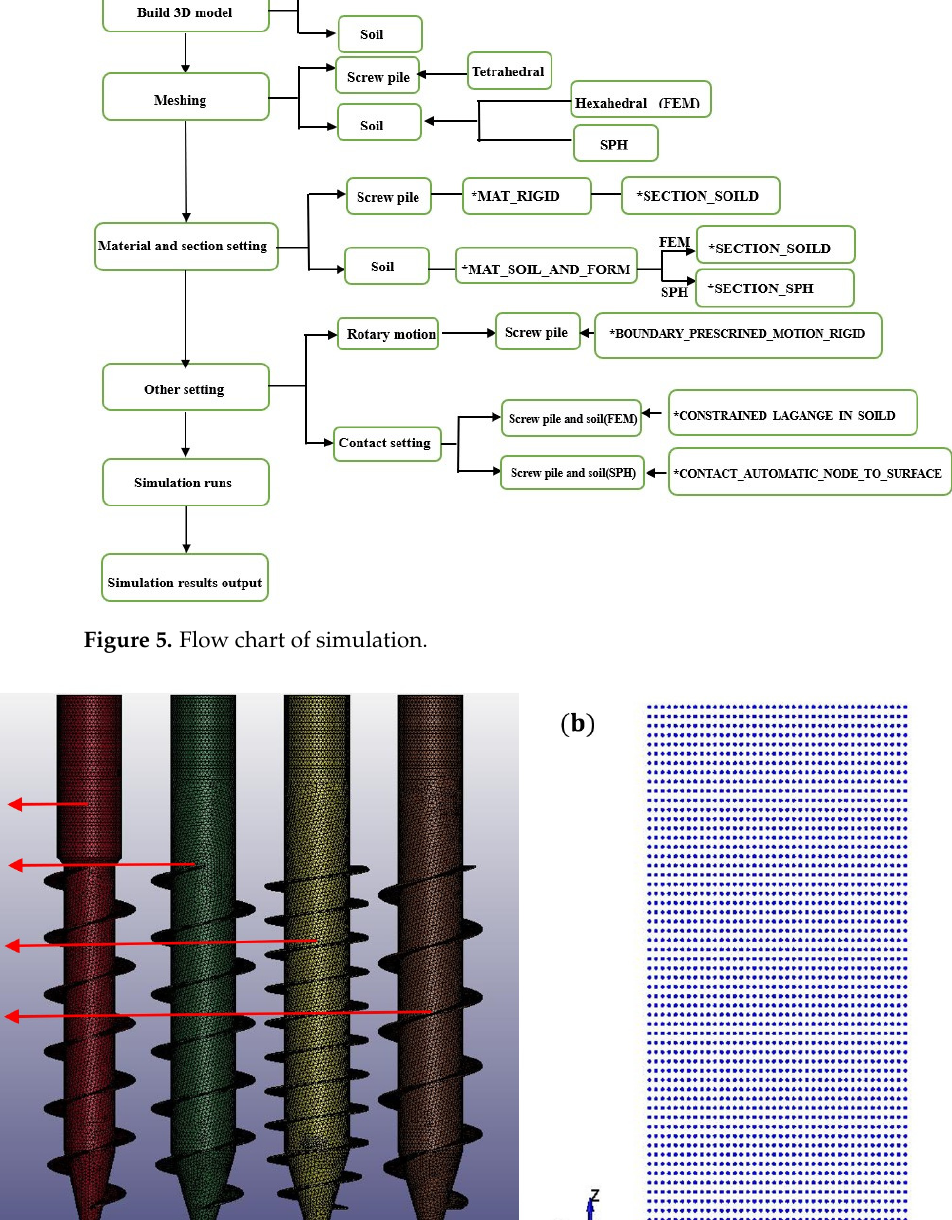
Figure 6. Numerical models: ( a ) FE screw pile model, ( b ) SPH soil model. Table 3. Material parameters of screw piles.